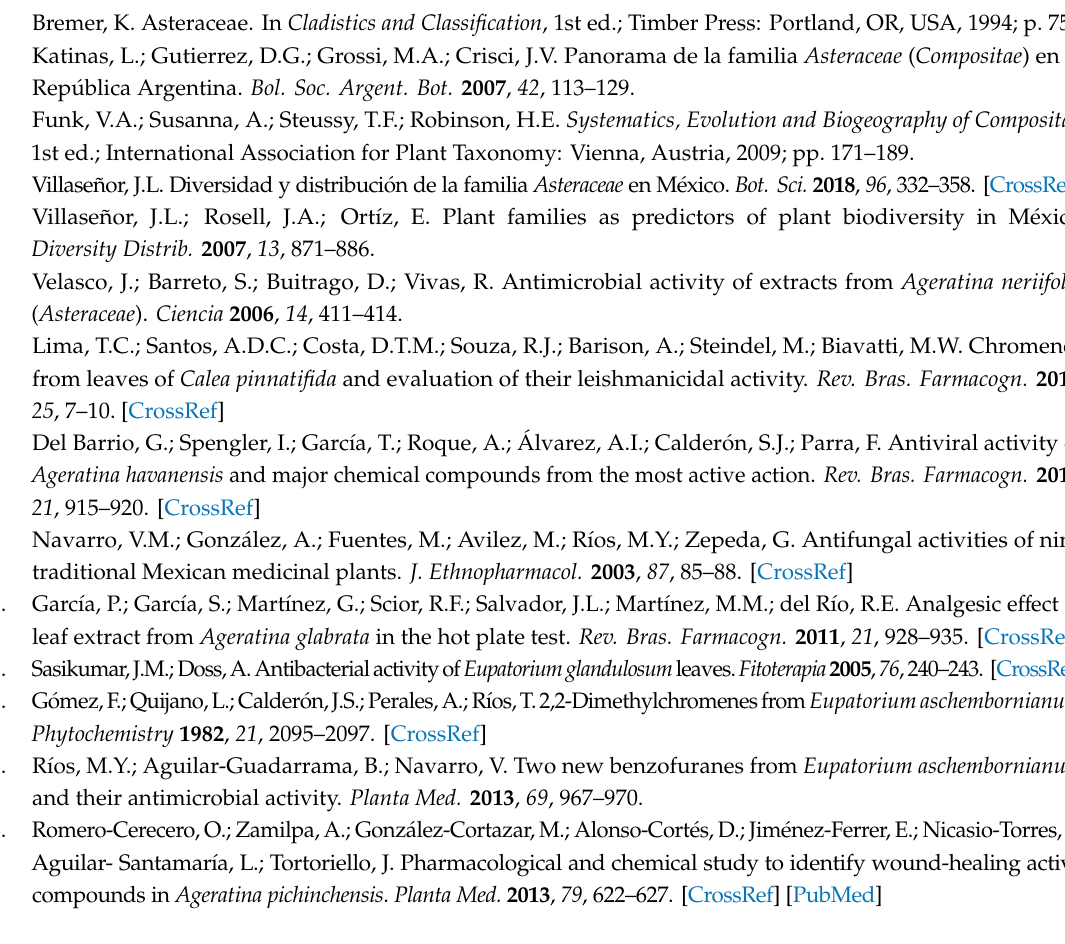
of compound 14, Figure S17a: GC-MS chromatogram of cell suspension culture extract with compounds 15-17, Figure S17b: Mass spectrum of compound 15, Figure S17c: Mass spectrum of compound 16, Figure S17d: Mass spectrum of compound 17, Figure S18a: GC-MS chromatogram of compounds 10-11 obtained of the ethyl acetate extract from wild plant A. pichinchensis, Figure S18b: GC-MS chromatograms of compound 10, Figure S18c: GC-MS chromatograms of compound 11, Figure S18d: GC-MS chromatograms of the compounds encecalin (10) and 3,5-diprenyl-4-hydroxyacetophenone (11) obtained of the ethyl acetate extract from A. pichinchensis cell suspension cultures, Figure S18e: GC-MS chromatogram of compound 10 obtained from acetate ethyl extract of cell suspension cultures, Figure S18f: GC-MS chromatogram of compound 11 obtained from acetate ethyl extract of cell suspension cultures, Figure S19: GC-MS chromatograms of standard compound and EtOAc extract. (a) 2,3-dihydrobenzofuran (2) profile used as a standard; (b) EtOAc extract profile from A. pichinchensis cell suspension culture at 8 days of culture showing the peak of 2,3-dihydrobenzofuran (2) compound, Figure S20: GC-MS chromatograms of standard compound and EtOAc extract. (a) 3-epilupeol (3) profile used as a standard; (b) EtOAc extract profile from A. pichinchensis cell suspension culture at 16 days of culture showing the peak of 3-epilupeol (3)